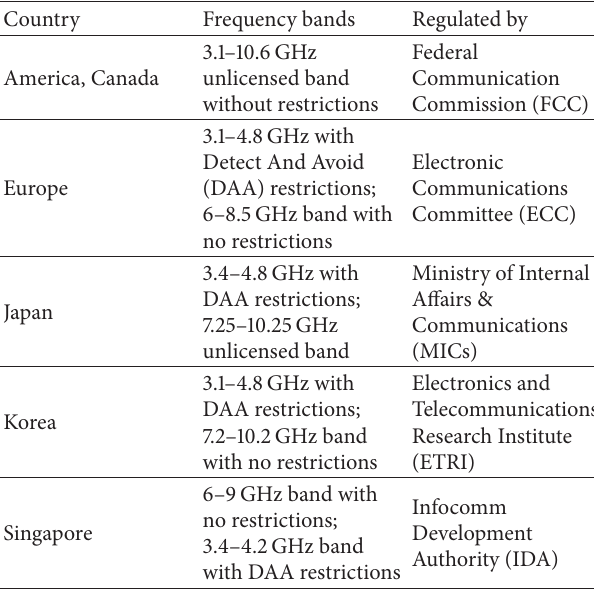
Table 1: UWB standards.